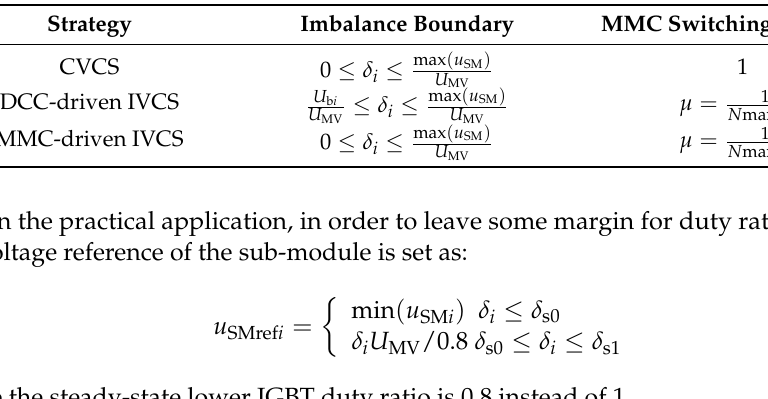
Table 1. Comparisons of the three kinds of control